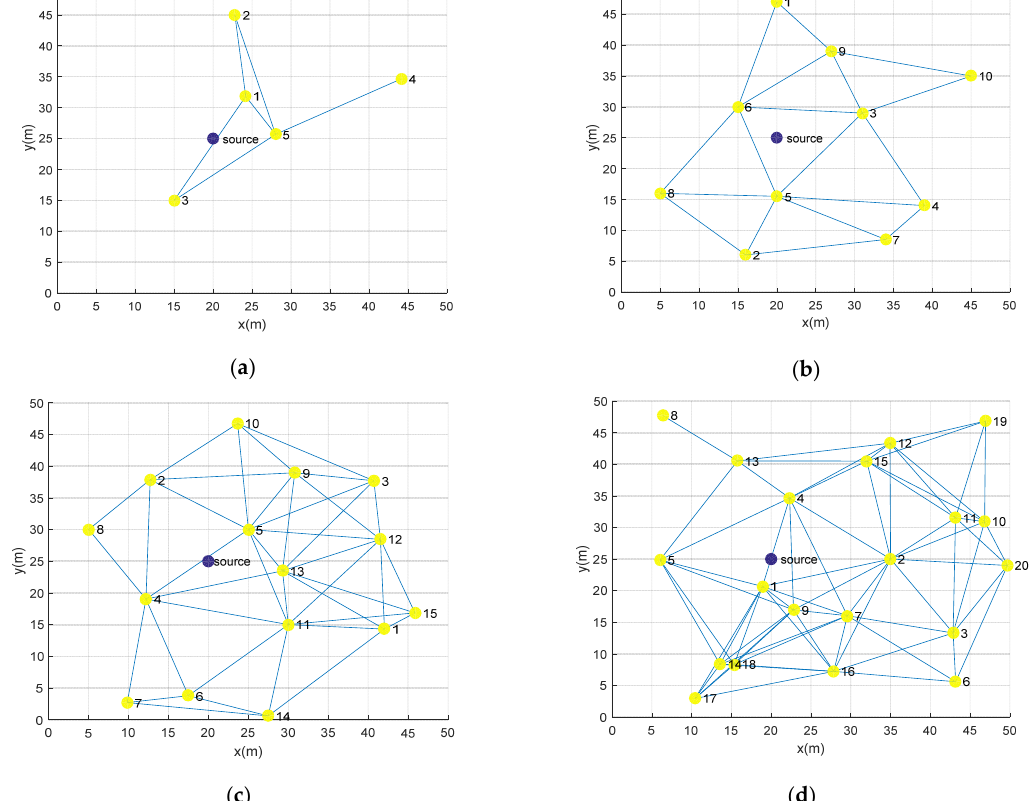
Figure 3. The topologies of four WASNs with different node numbers: ( a ) 5 nodes; ( b ) 10 nodes; ( c ) 15 nodes; ( d ) 20 nodes.